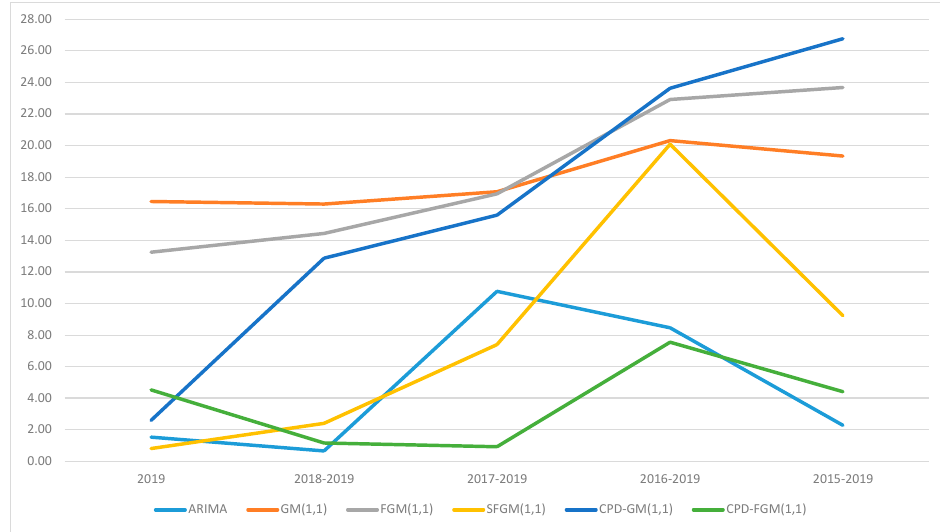
Figure 5. The MAPE of the six comparison models for different test sets.